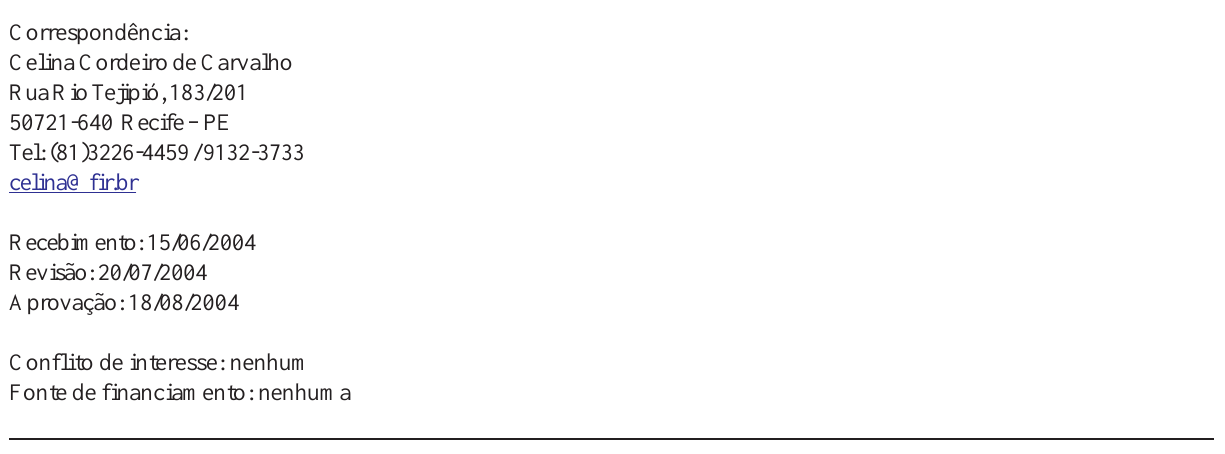
*Figuras coloridas disponíveis em